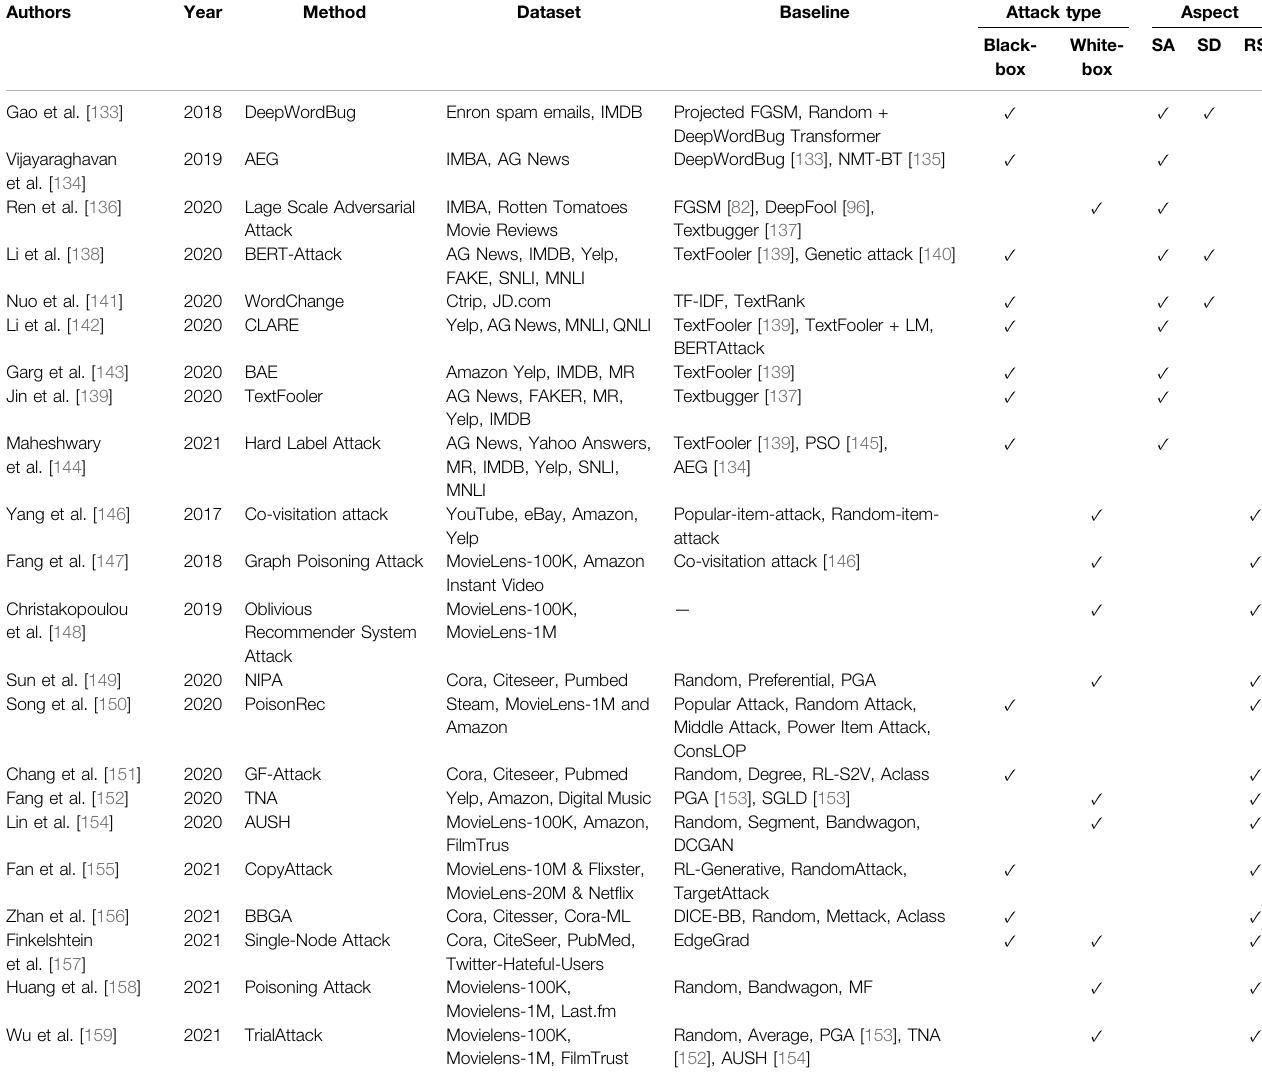
TABLE 4 | Attack to machine learning in social